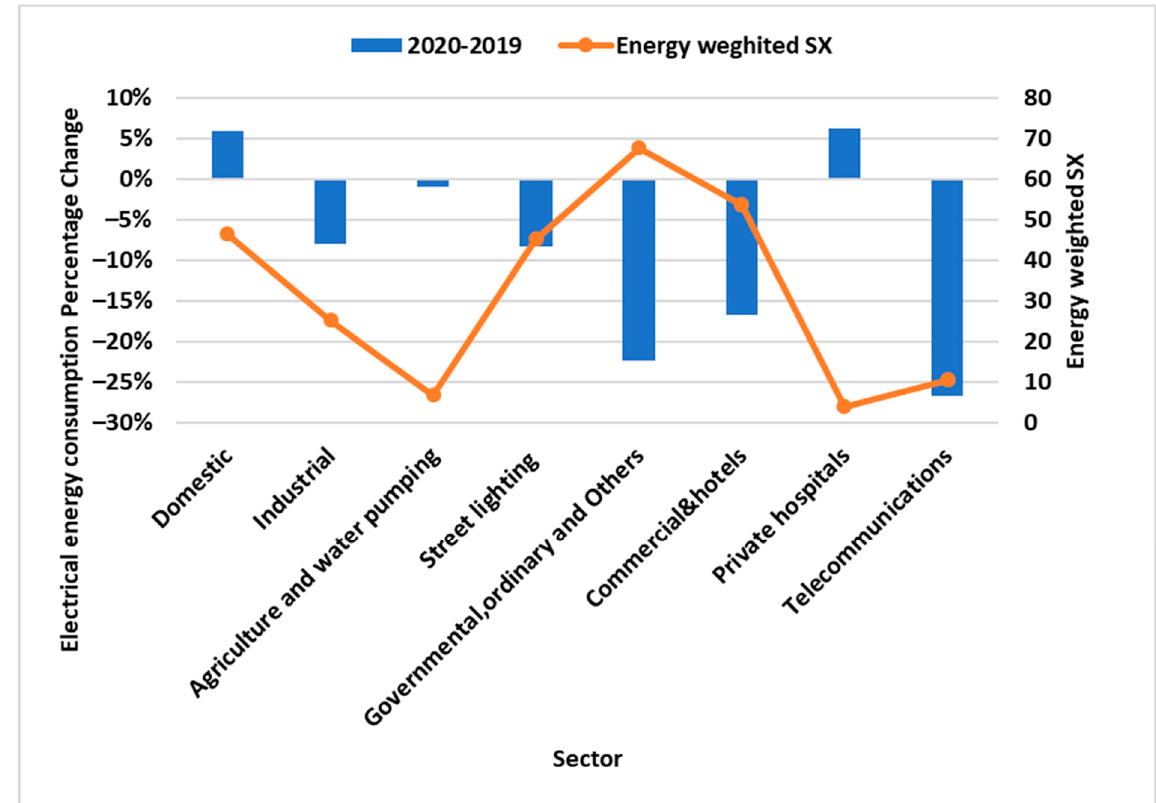
Figure 12. Change in electricity consumption at JEPCO’s region between 2019 and 2020 for the different sectors with EWSX.